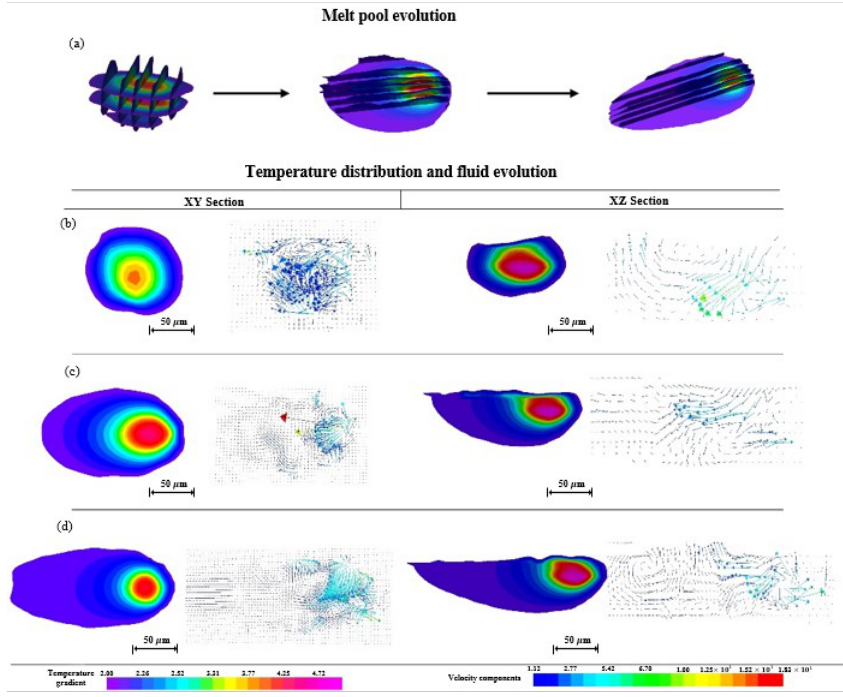
Figure 12. Evolution of melt pool geometry ( a ); evolution of temperature gradient and fluid flow at initial ( b ), intermediate ( c ), and end ( d ) positions of single scanning track in XY and XZ sections, respectively.